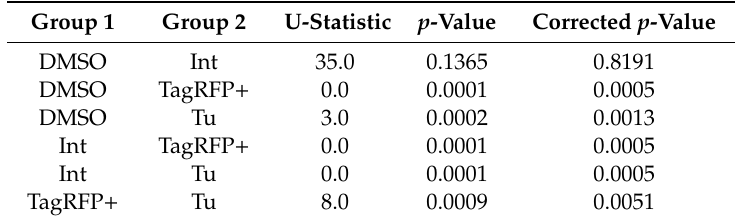
Table 2. Statistical Analysis of Red Cells Percentage Change at the End of ER stress Time Course 1